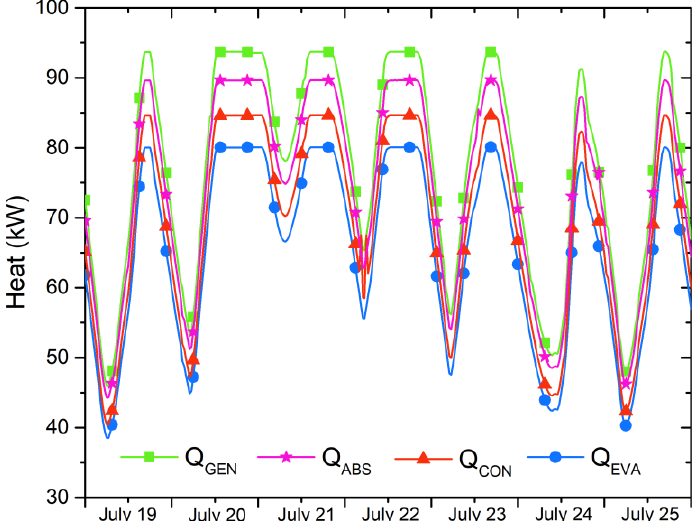
Figure 8. Operational performance of Q GEN , Q EVA , Q CON , and Q ABS heat exchangers during the critical summer week.